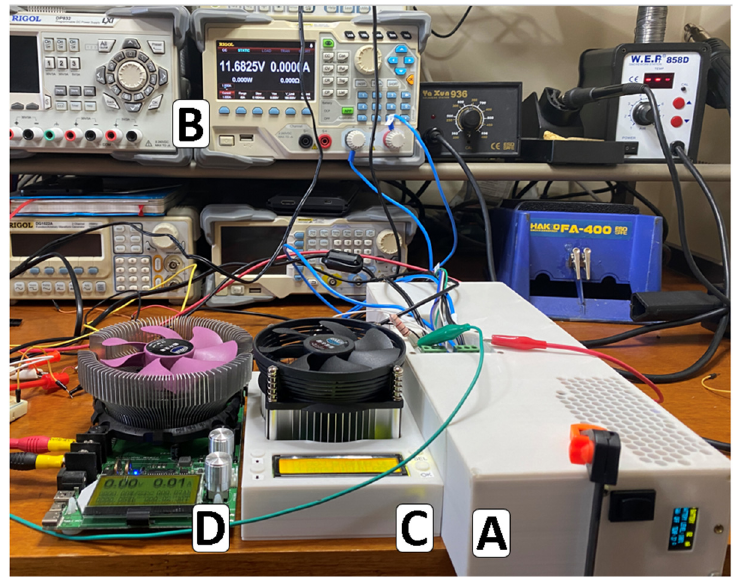
Figure 11. Power supply ( A ) and electronic loads ( B – D ) used in the first test.